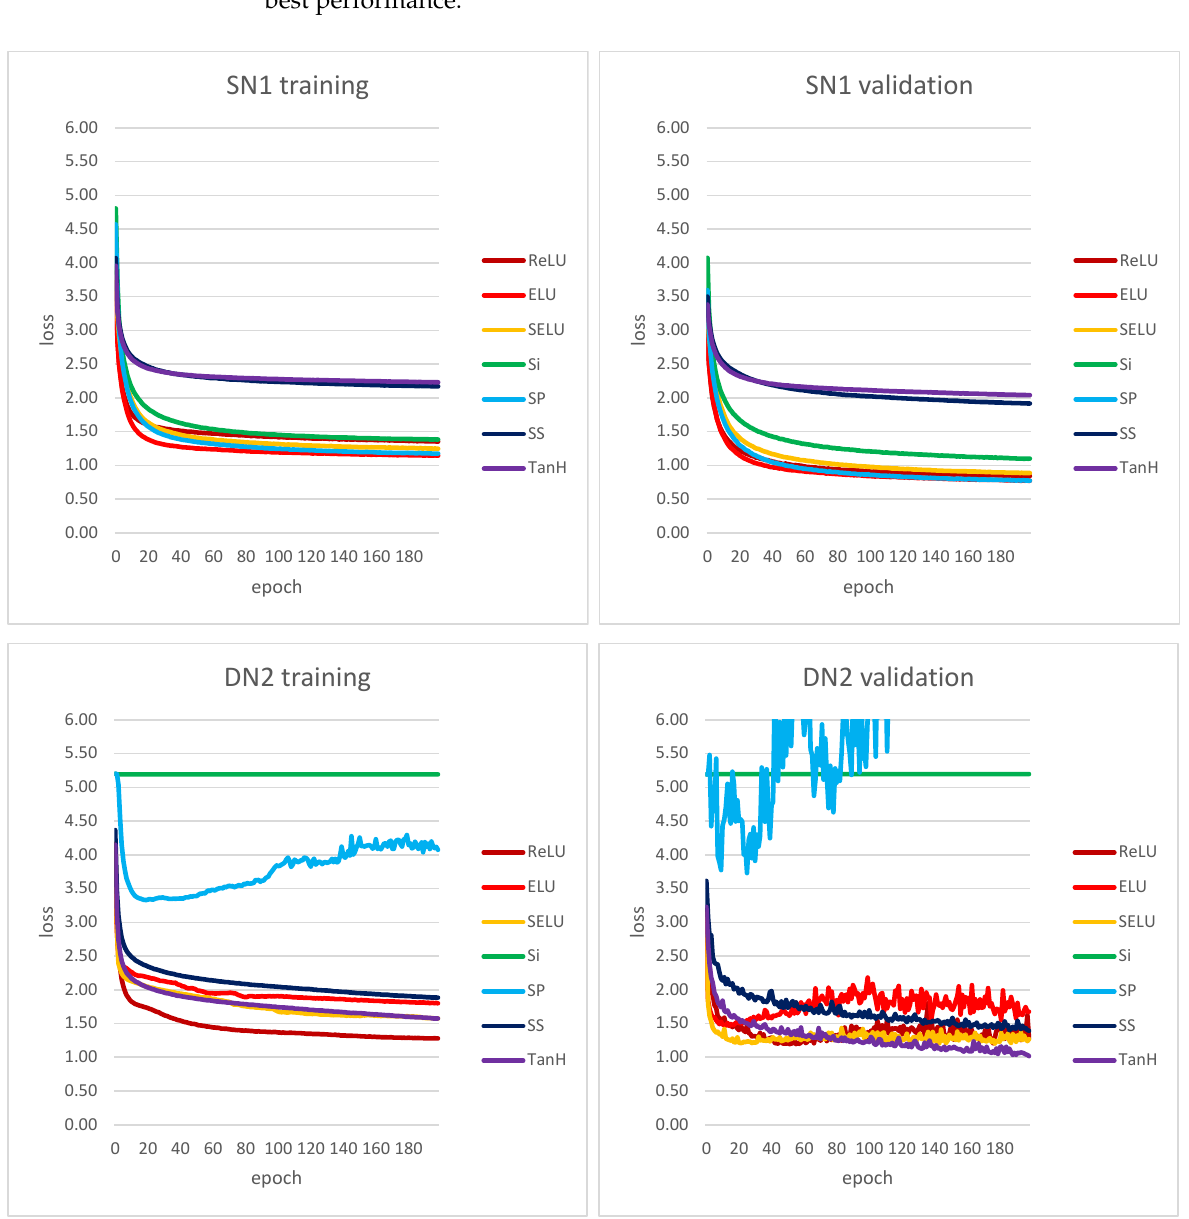
Figure 5. Training and validation loss curves for the best performing shallow and deep CNNs (best performing replicate). For DN2 validation plot, the SP plot was clipped due to its large fluctuations to keep the most appropriate plot scale. For the loss function, please refer to Equation (2) and related text.